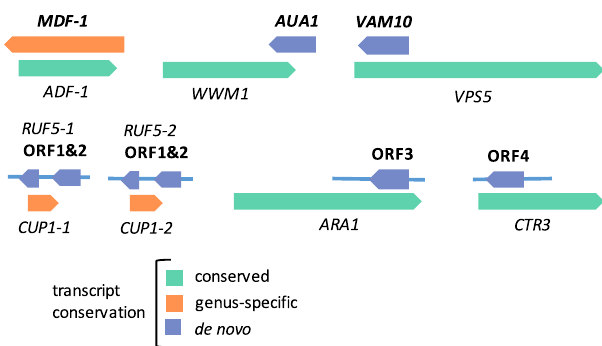
Fig. 6 Examples of de novo proteins in sense – antisense gene pairs. The thick arrows represent coding sequences whereas the lines represent the rest of the transcript as de fi ned by our pipeline. ORF denotes open reading frames that are not annotated but which are translated proteins according to the analysis of ribosome pro fi ling data. For convenience the youngest protein (in bold) is always shown in the upper part of the diagram, regardless of whether it is in the positive or negative strand. This representation focuses on the conservation at the level of the transcript. The conservation of the protein may be more restricted as is the case of MDF1 , which is only found in S. cerevisiae